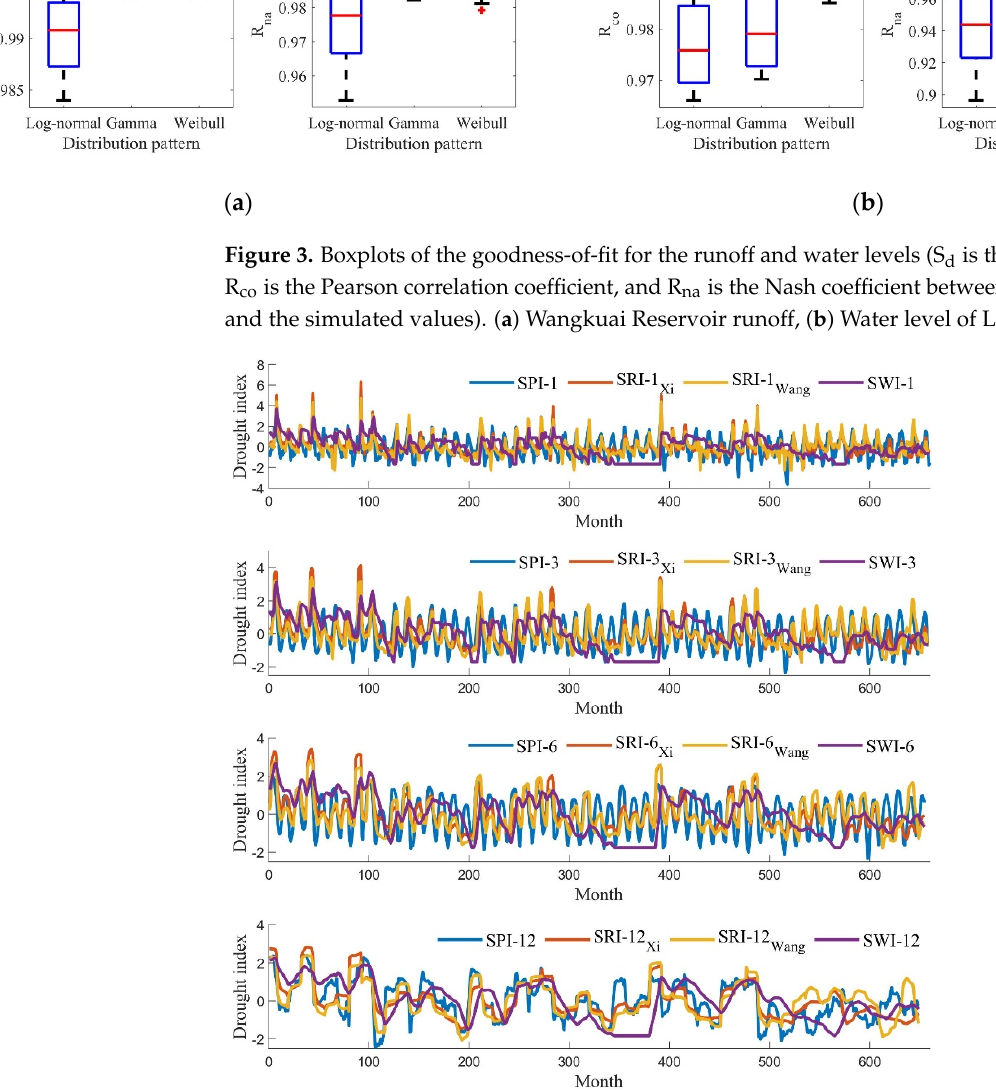
Figure 5. Drought characteristics of the SPI, SRI Xi , SRI Wang , and SWI at different timescales (PI de- notes the absolute values).